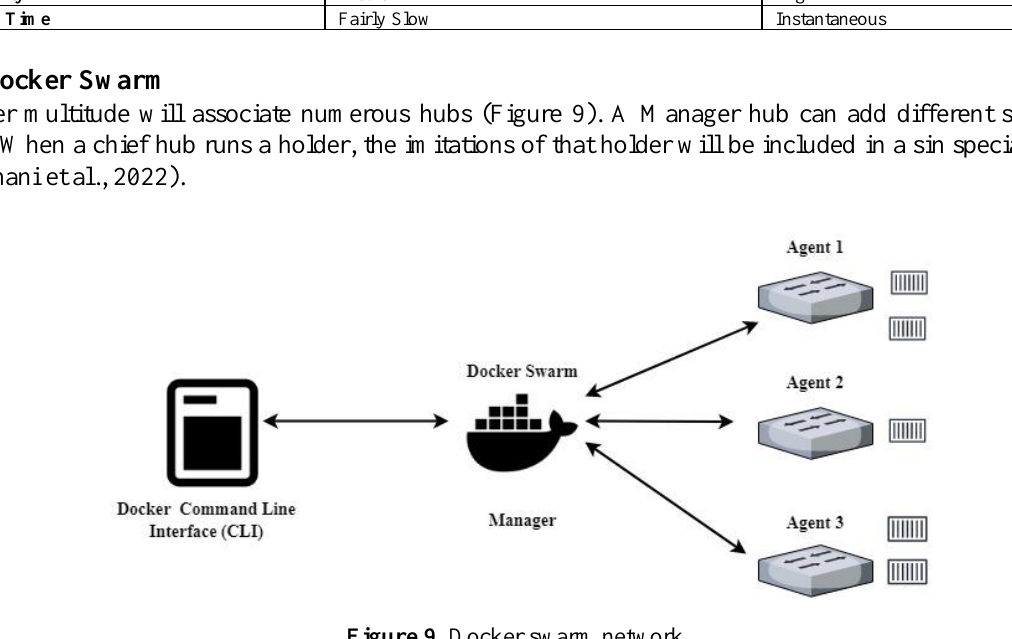
Figure 9. Docker swarm network.